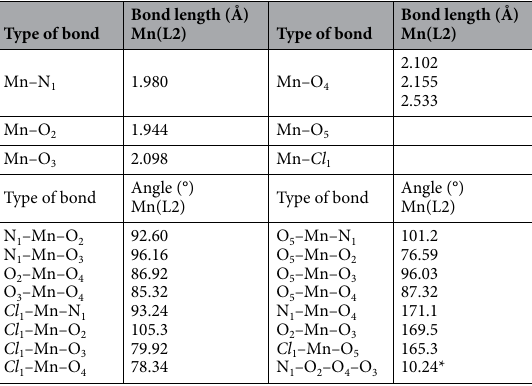
Table 8. Important optimized bond lengths (Å) and bond angles (°) of [Mn(L2)(H 2 O) 2 Cl 2 ]. *dihedral angle.